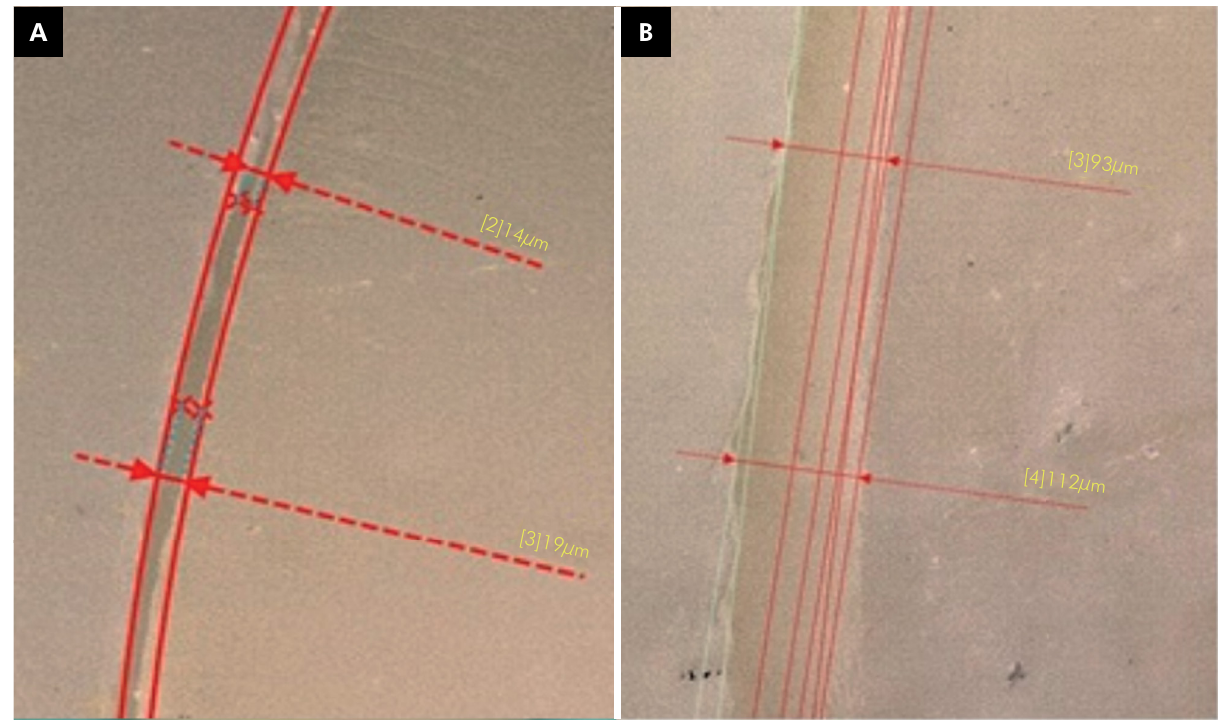
Figure 2. Example of the measurements done on a lithium disilicate pressed and CAD/CAM crown.